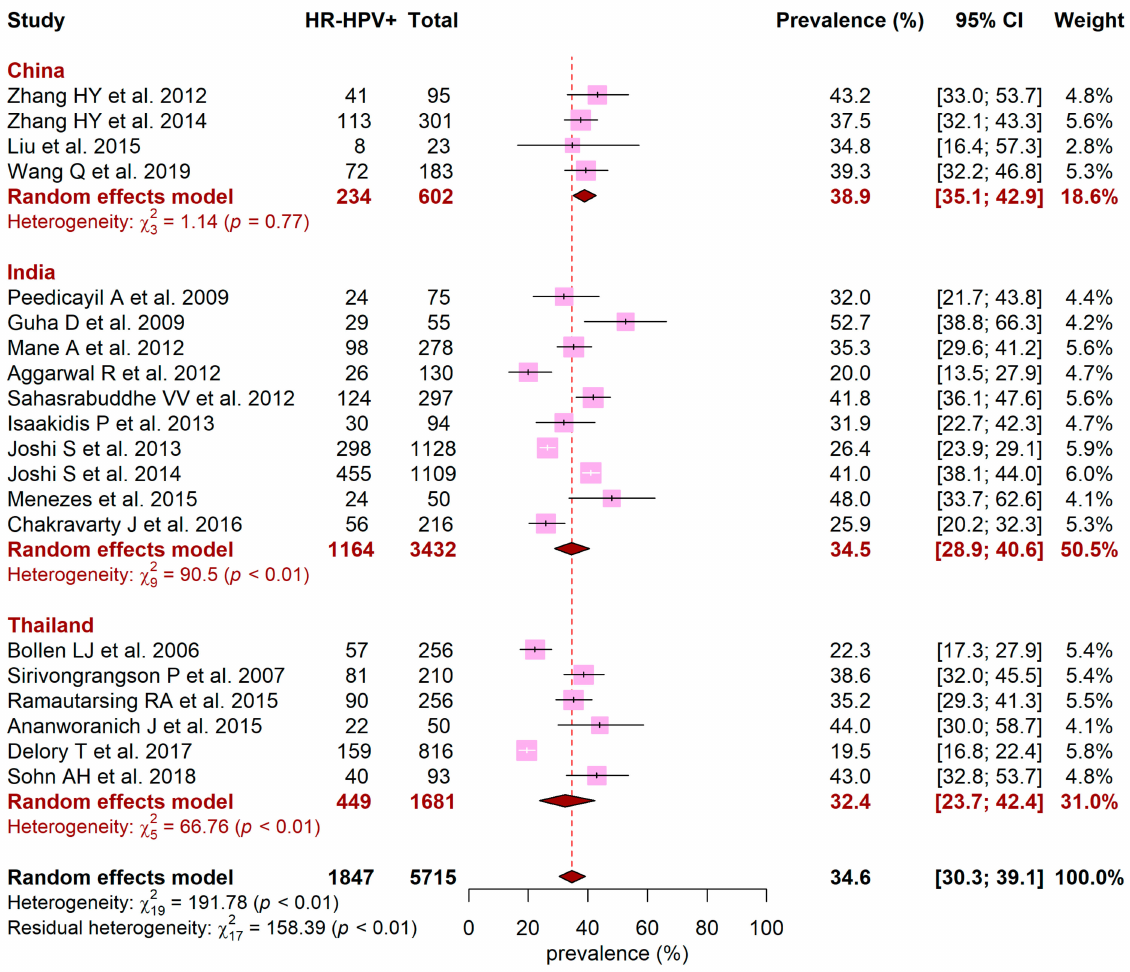
Figure 3. Forest plot of HR-HPV prevalence across China, India, and Thailand. Meta-analyses with random-effects models. HR-HPV: high-risk human papillomavirus; CI: confidence